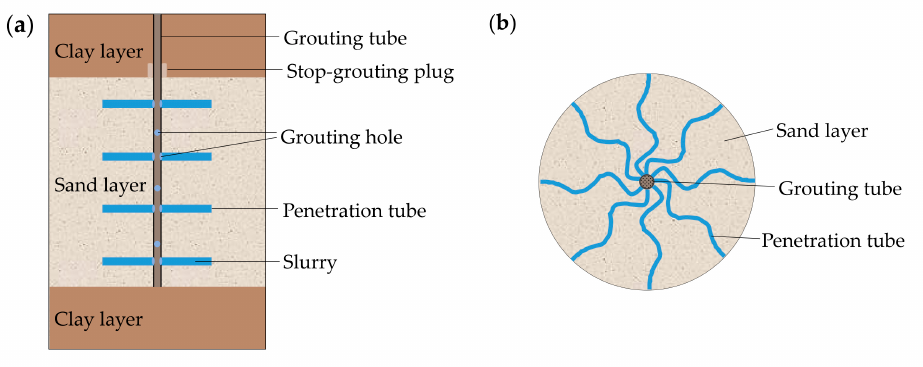
Figure 1. Cylindrical permeation and diffusion model of tortuous tubes: ( a ) front view; ( b ) top view. Tortuosity is a parameter that can characterize the circuitous degree of penetration pore channels, which represents the ratio of the actual length of penetration path to the effective length of penetration path. The schematic diagram of tortuosity effect is shown in Figure 2. The definition of tortuosity is: